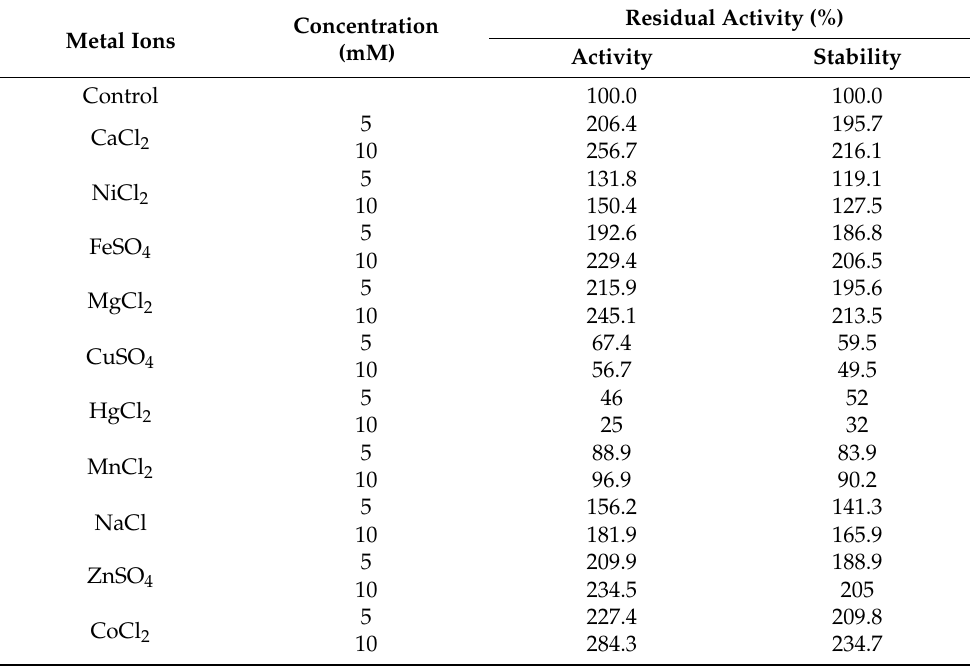
Table 4. Effect of metal ions on enzyme activity and stability.